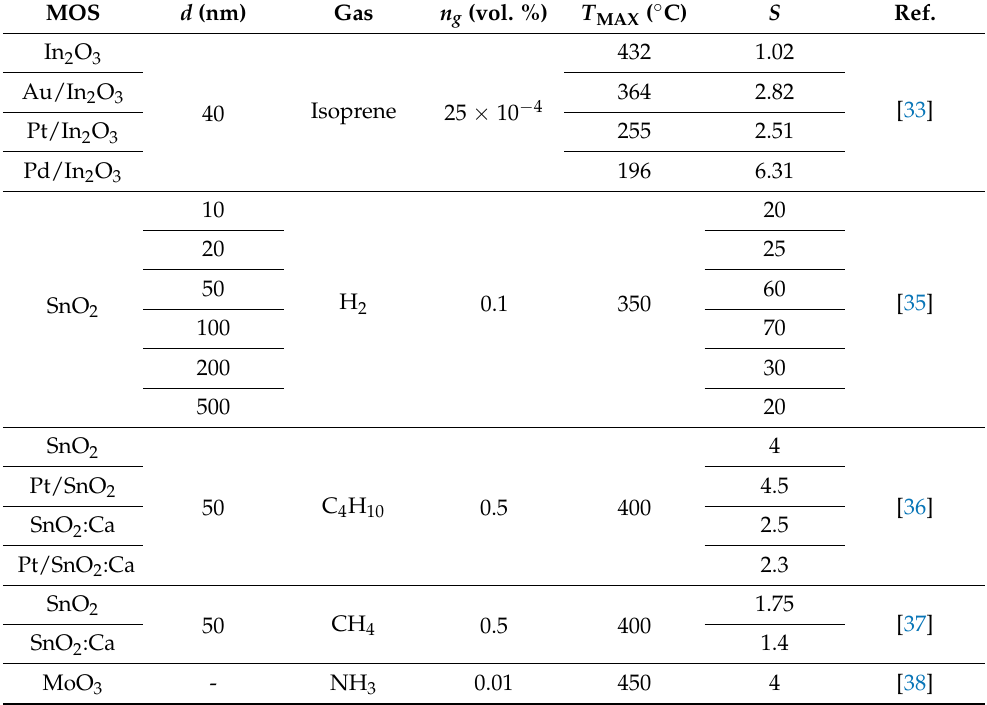
Table 1. Gas sensitive characteristics of IBSD metal oxide semiconductors (MOS) thin films.